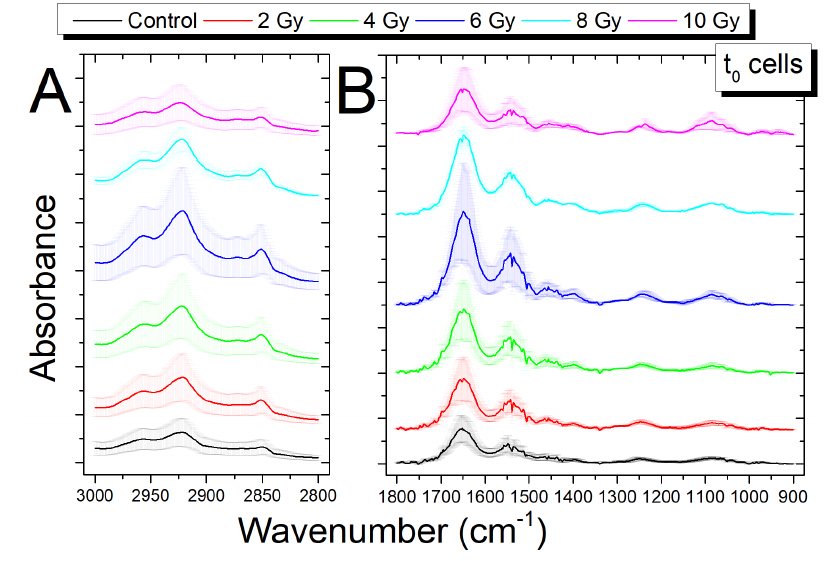
Figure 3. Comparison of average Fourier transform infrared (FTIR) spectra in the region 3000–2700 cm − 1 ( A ) and in the region 1800–900 cm − 1 ( B ) between the control cells (0 Gy) and irradiated cells (2, 4, 6, 8, 10 Gy) fixed immediately after irradiation; the spectra are shifted in absorbance to allow the comparison, data are presented as MEAN ± SD.